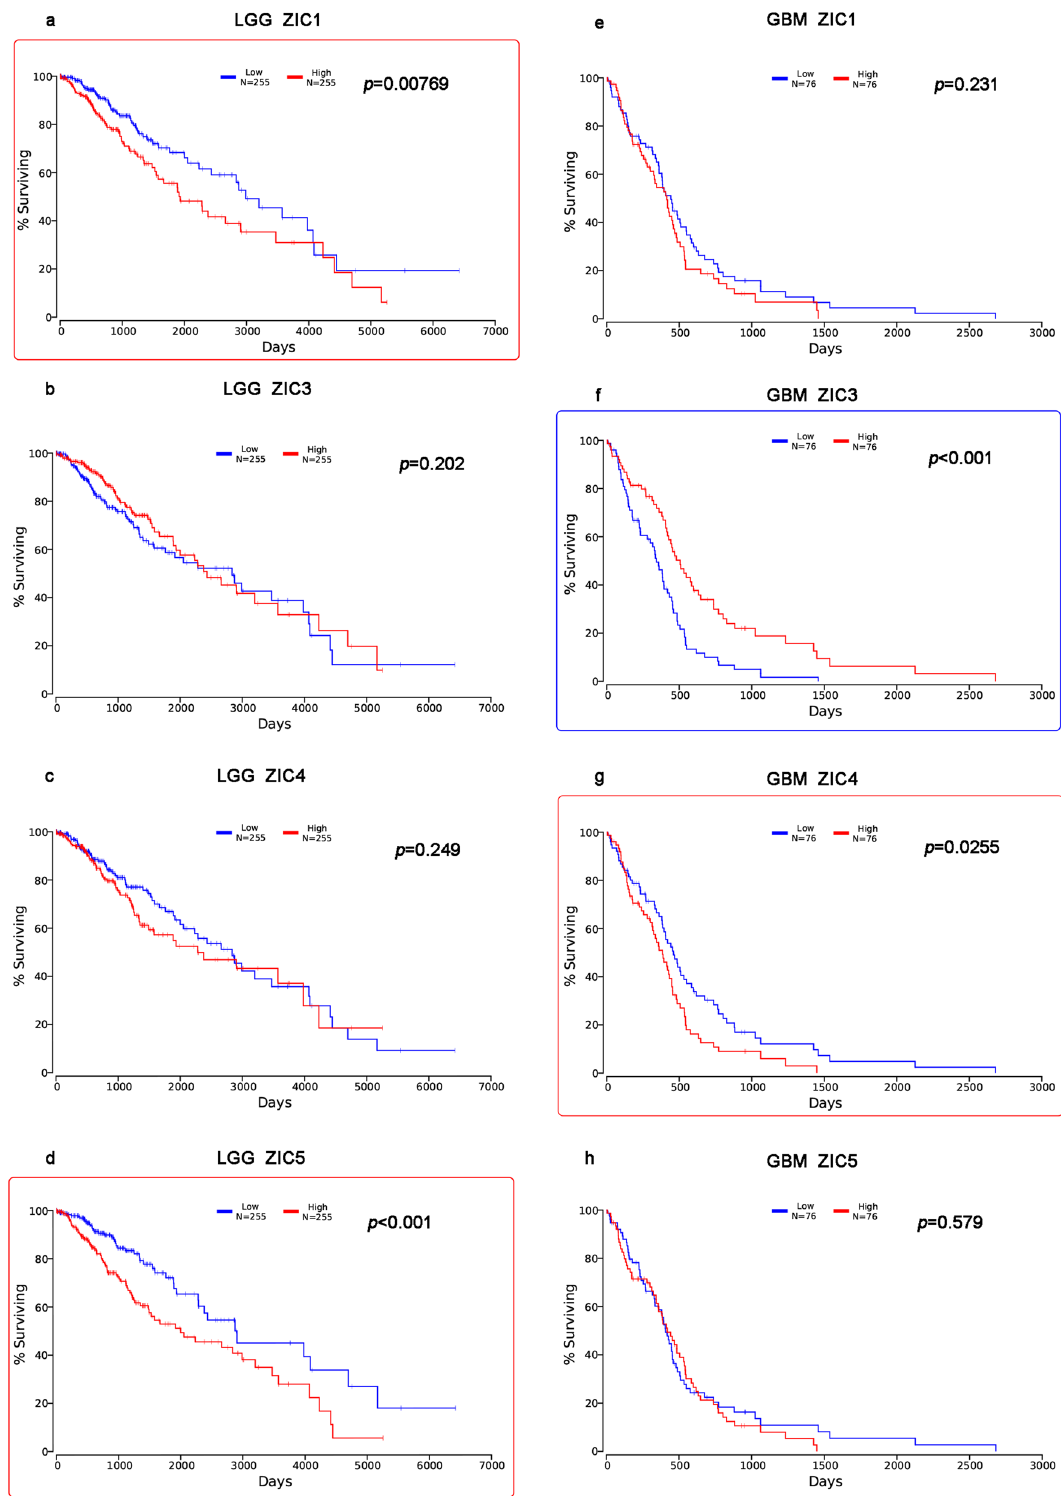
Figure 3. Prognostic value of ZIC family member mRNA expression in LGG and GBM patients (OncoLnc). The framed images contain parameters that were found to have prognostic relevance. High mRNA expression of ZIC1/5 individual was associated with poor OS in LGG patients ( a , d ). Low mRNA expression of ZIC3 was significantly associated with poor OS in GBM patients ( f ), while high expression of ZIC4 was significantly related to unfavorable OS in GBM patients ( g ). ZIC1/5 was not related to the OS in GBM patients ( e , h ), and ZIC3/4 was not related to the OS in LGG patients ( b , c